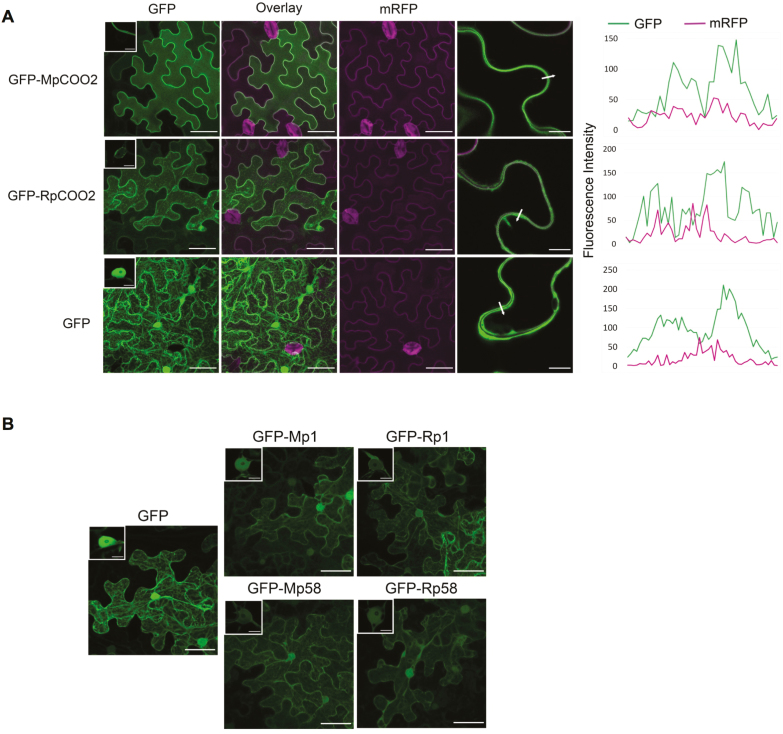
Localization of aphid effectors in Nicotiana benthamiana. (A) Confocal microscopy images of free GFP (empty vector, pB7WG2F), and effectors GFP–MpC002 and GFP–RpC002 (middle section) transiently overexpressed in N. benthamiana. Both effectors were co-expressed with a plasma membrane marker (Wang et al., 2017). Merged images represent the overlay image of the GFP and mRFP (monomeric red fluorescent protein) channels. Scale bars represent 50 µm for the main images and 10 µm for the insets. The images in the last column are at higher magnification, with scale bars representing 10 µm. The arrows across the plasma membranes and apoplast of adjacent cells indicate paths used for the fluorescence intensity profiles of mRFP and GFP; the profile graphs are shown at the right of the image sets. The images were taken 3 d after agroinfiltration. The co-localization was analysed by Fiji software and the plugin RGB profiler. (B) Confocal microscopy images of free GFP alone (pB7WG2F), and effectors GFP–Mp1/GFP–Rp1 and GFP–Mp58/Rp58. The insets show single optical sections through nuclei. Scale bars are 50 μm for the main images and 10 μm for the insets. (This figure is available in colour at JXB online.)